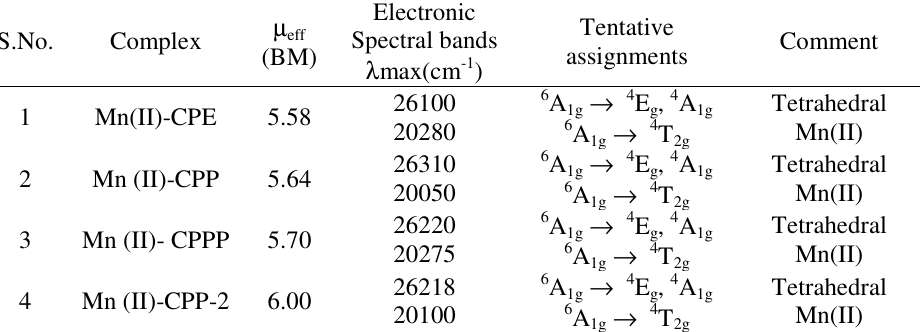
Table 3. Magnetic moments and electronic spectral data of the Mn(II) complexes.